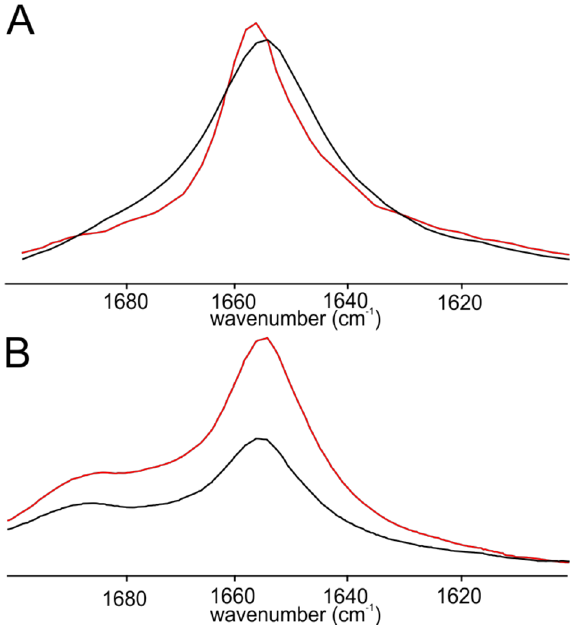
Figure 3. ATR- FTIR spectra of ( A ) CRAC-TM_model and ( B ) CRAC-TM_gp41 reconstituted into POPC (black) or POPC/cholesterol 70/30 mol/mole membranes (red).